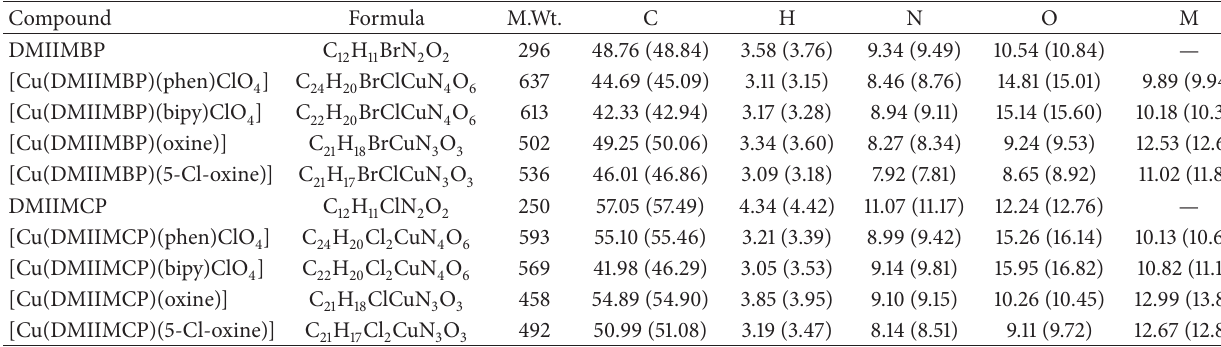
Table 1: Analytical data of Schiff bases and their metal